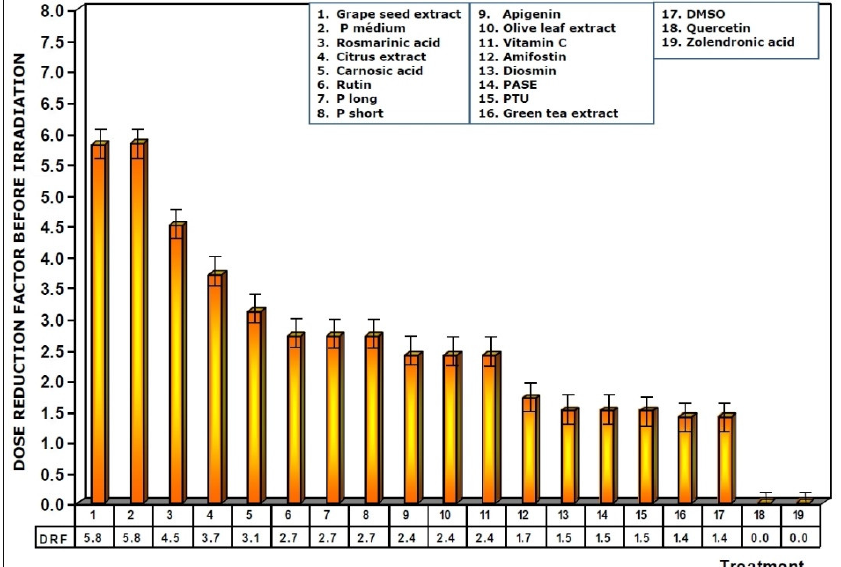
Figure 5. Dose reduction factors (DRF) obtained when the test substances were administered imme- diately before exposure to ionizing